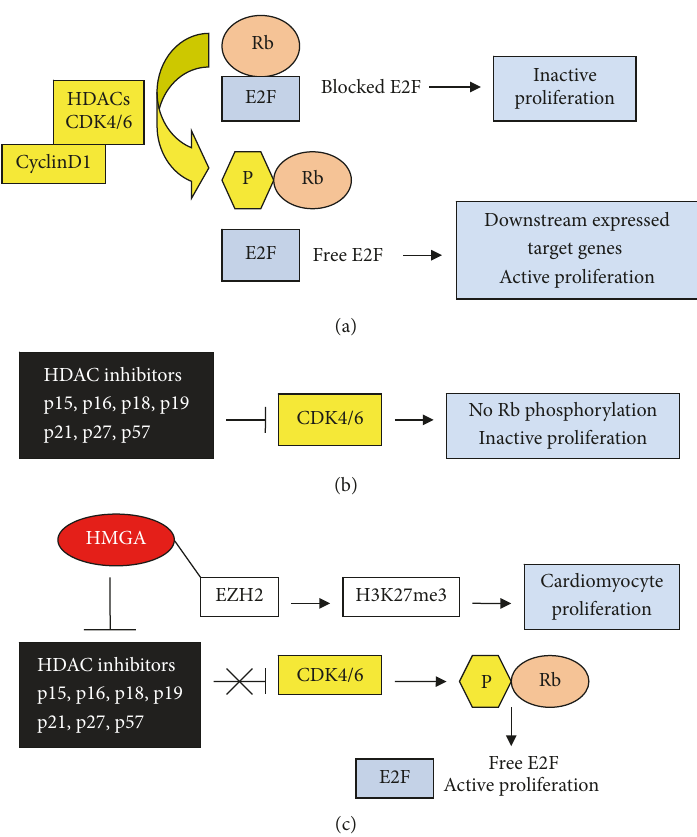
Figure 3: Rb and E2F in CSCs. (a) Phosphorylated Rb dissociates from E2F that induces proliferation factors; (b) blocking of Rb CDK4/6 kinases prevents Rb phosphorylation and inactivates proliferation; (c) HMGA proteins inhibit CDK4/6 Rb kinases and block cycle repressing- factors: proliferation is reactivated. Symbols are the same as shown in Figure